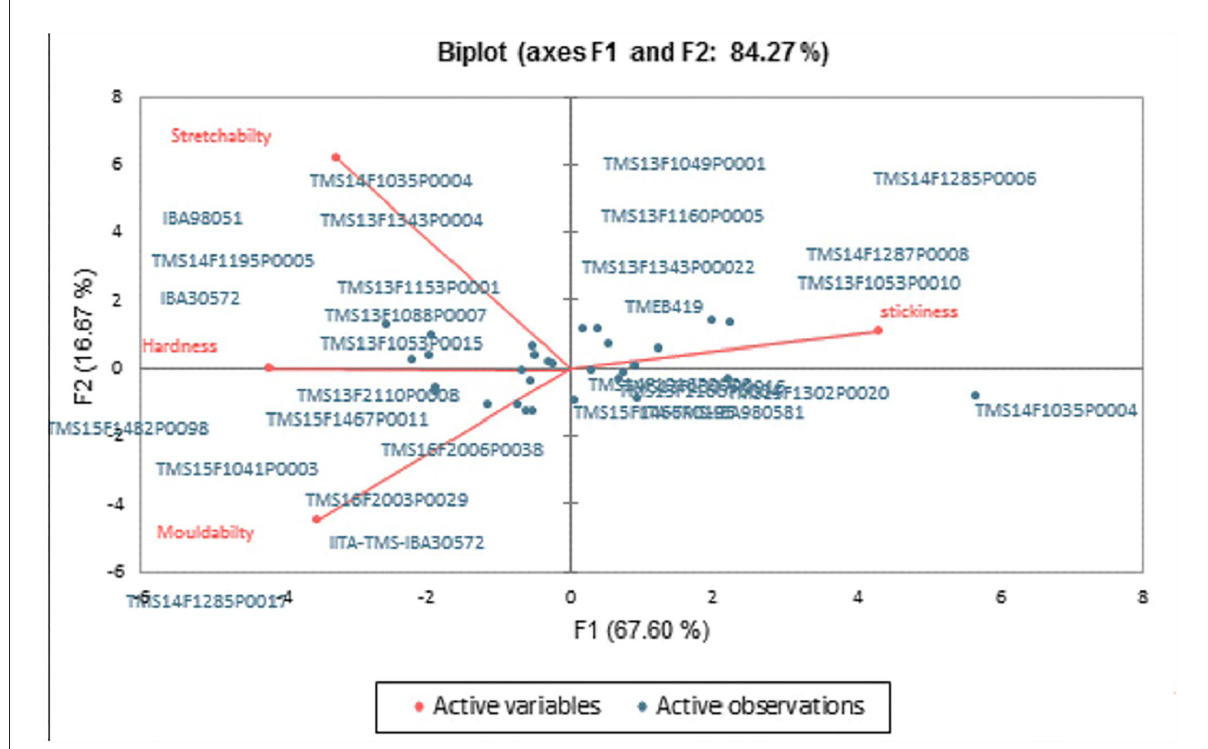
FIGURE5 The principal component analysis biplot of the sensory texture attributes of eba from different gari samples.